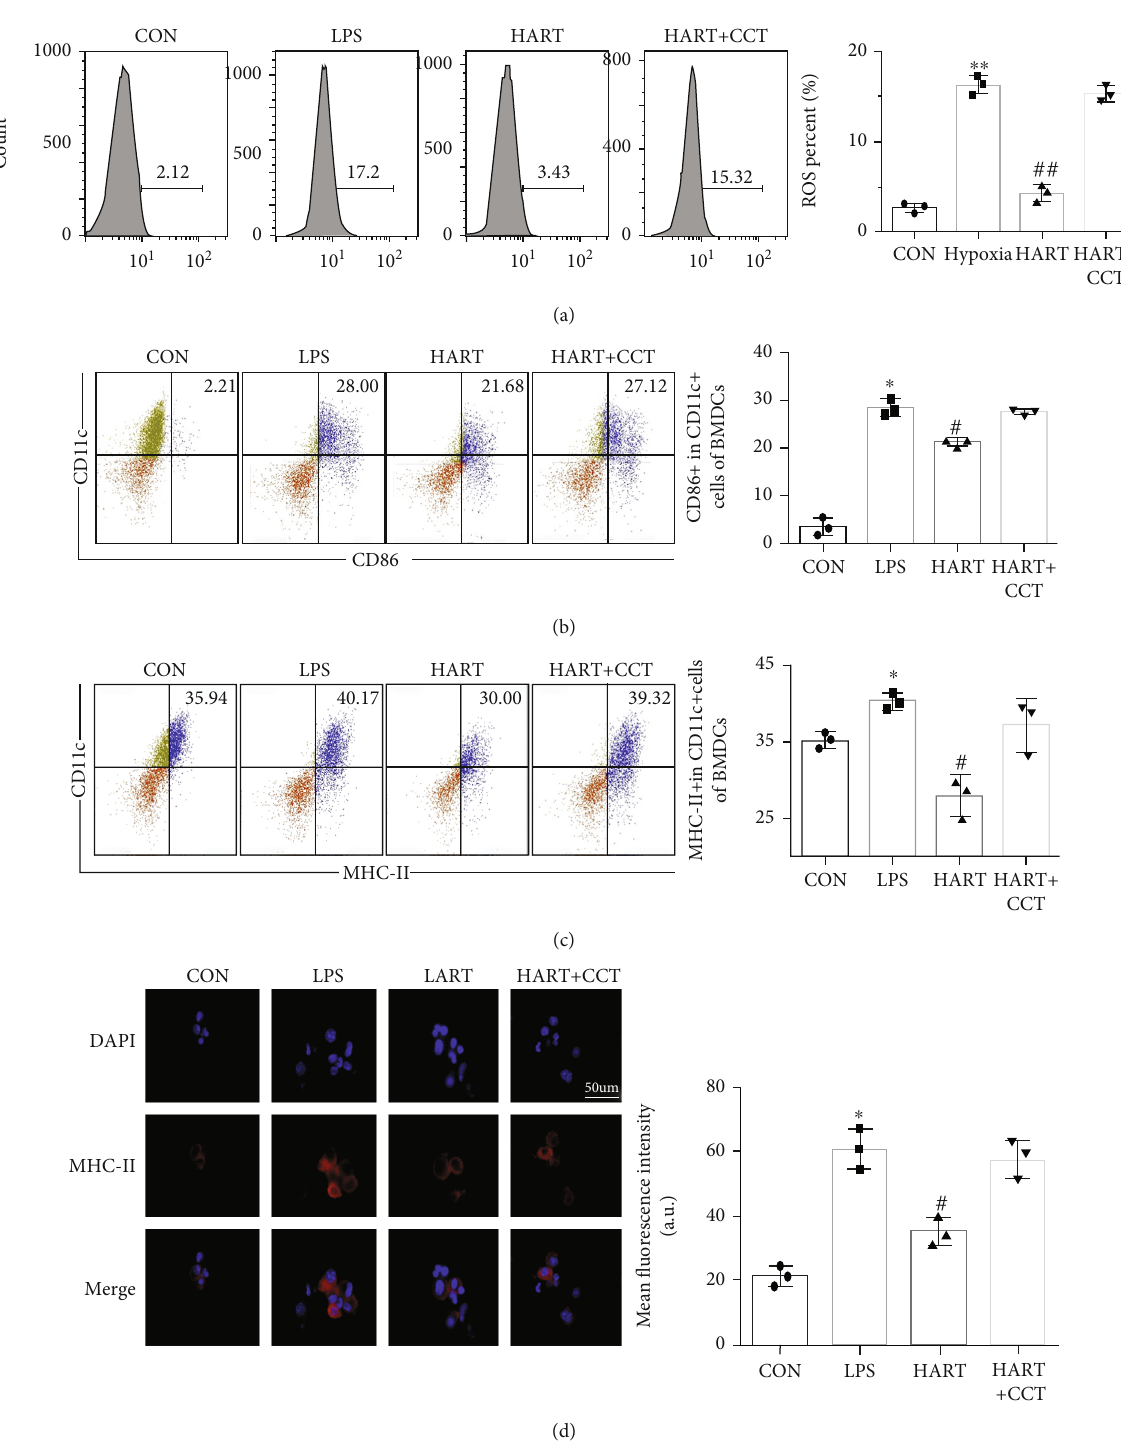
Figure 6: (a) ROS of DCs after LPS and CCT ( ∗∗ P < 0 : 01 compared with CON; ## P < 0 : 01 compared with LPS); (b) fl ow cytometric sorting of CD11c+ and CD86+ cells in BMDCs; (c) fl ow cytometric sorting of CD11c+ and MHC-II+ cells in BMDCs ( ∗ P < 0 : 05 compared with CON; # P < 0 : 05 compared with LPS); (d) immuno fl uorescence staining and mean fl uorescence intensity of MHC-II in BMDCs (blue: DAPI, red: